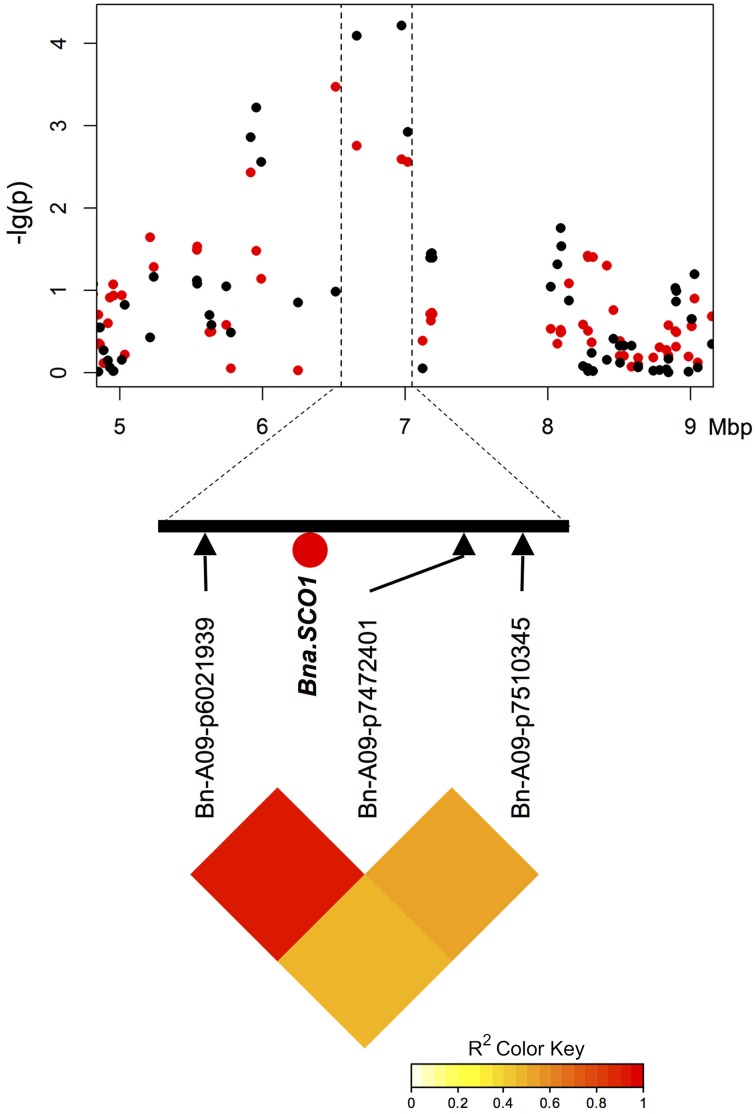
Manhattan plot describing marker-trait associations for the trait T50 within the chromosomal region around candidate BnaA09g12770D (Bna.SCO1) on chromosome A9, and correlations between the associated marker and both flanking markers. Red dots represent associations calculated for SL2011. Black dots represent associations for SL2012.